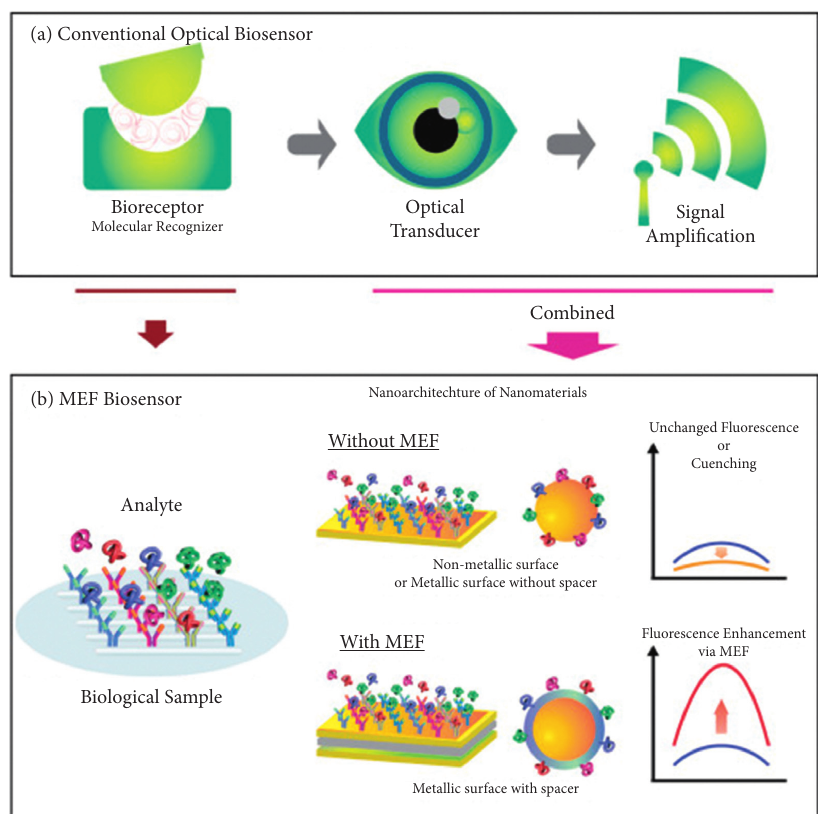
Figure 10: Scheme of metal-enhanced fluorescence (MEF)